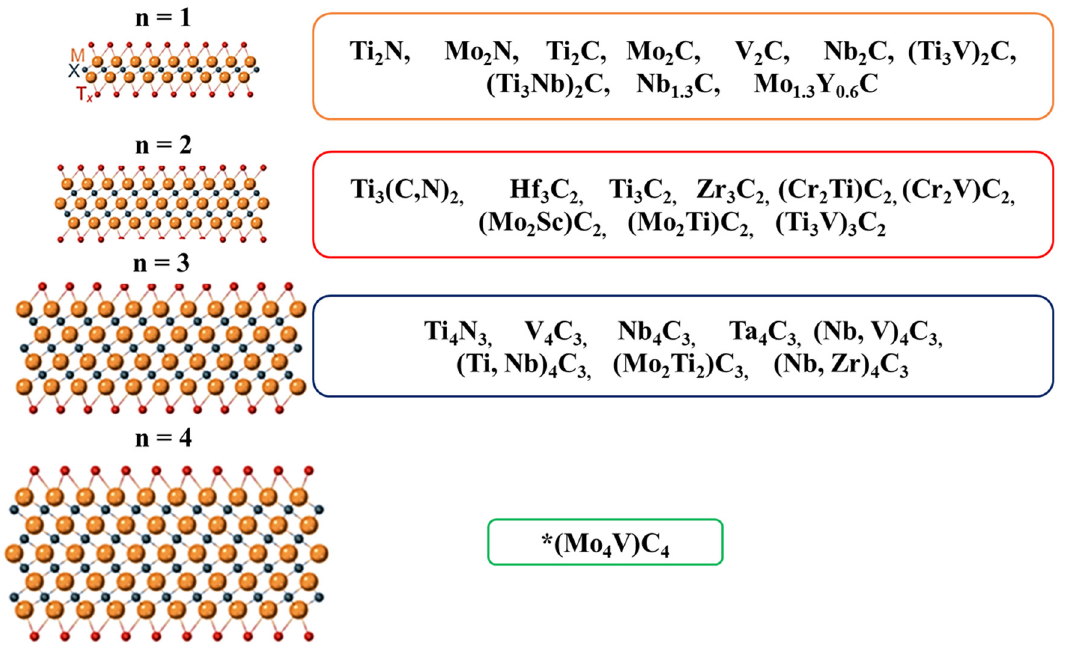
Figure 1. The list of studied MAX and MXene nanocomposites.